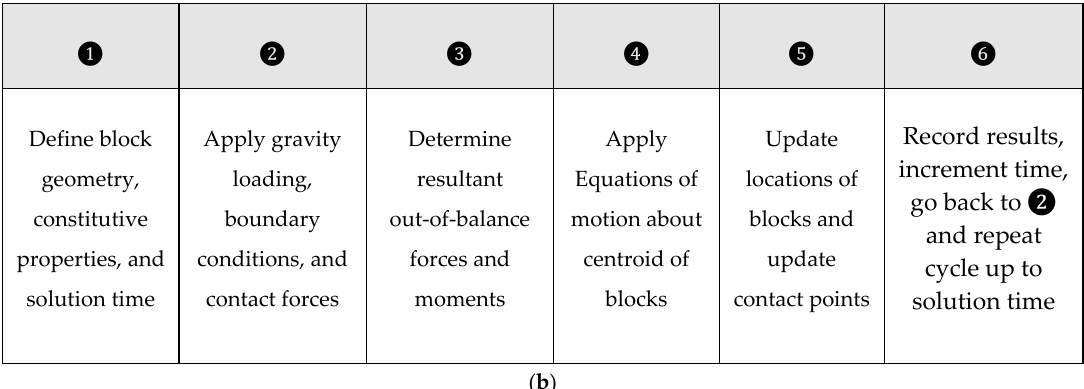
Figure 3. ( a ) Schematic of the numerical model. ( b ) Calculation cycle steps for the distinct element method.